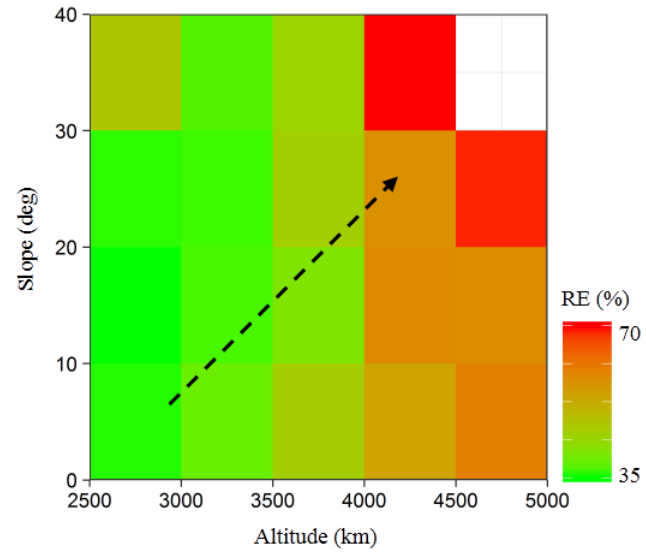
Figure 5. Relationships between topographic factors and inconsistency in the MODIS GPP at 500 m and 1 km during Julian days